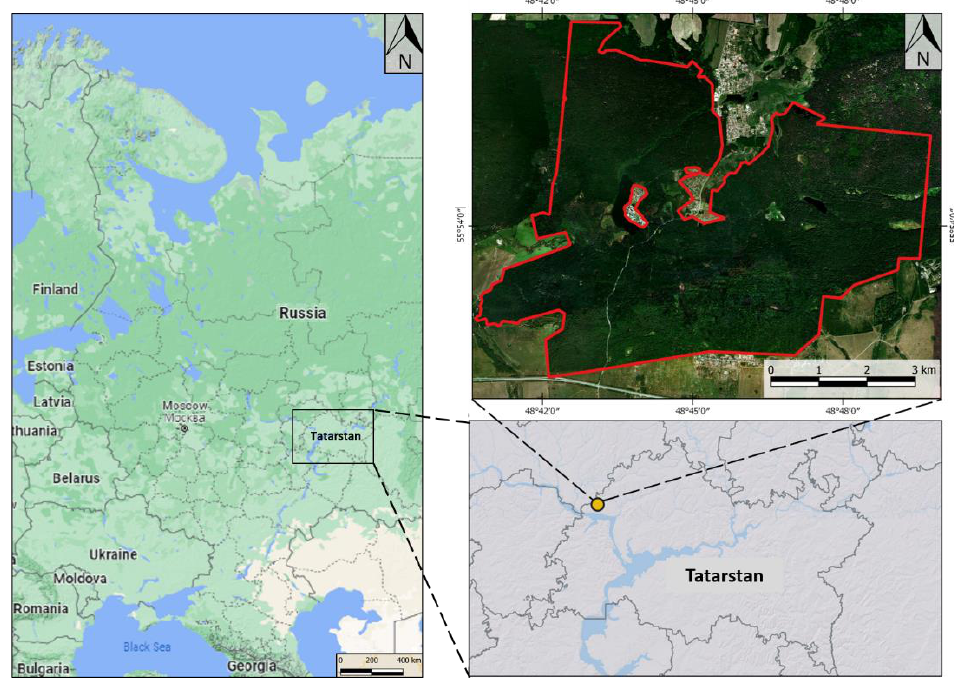
Figure 1. Study area: Raifa forest (section of Volga – Kama State Reserve).